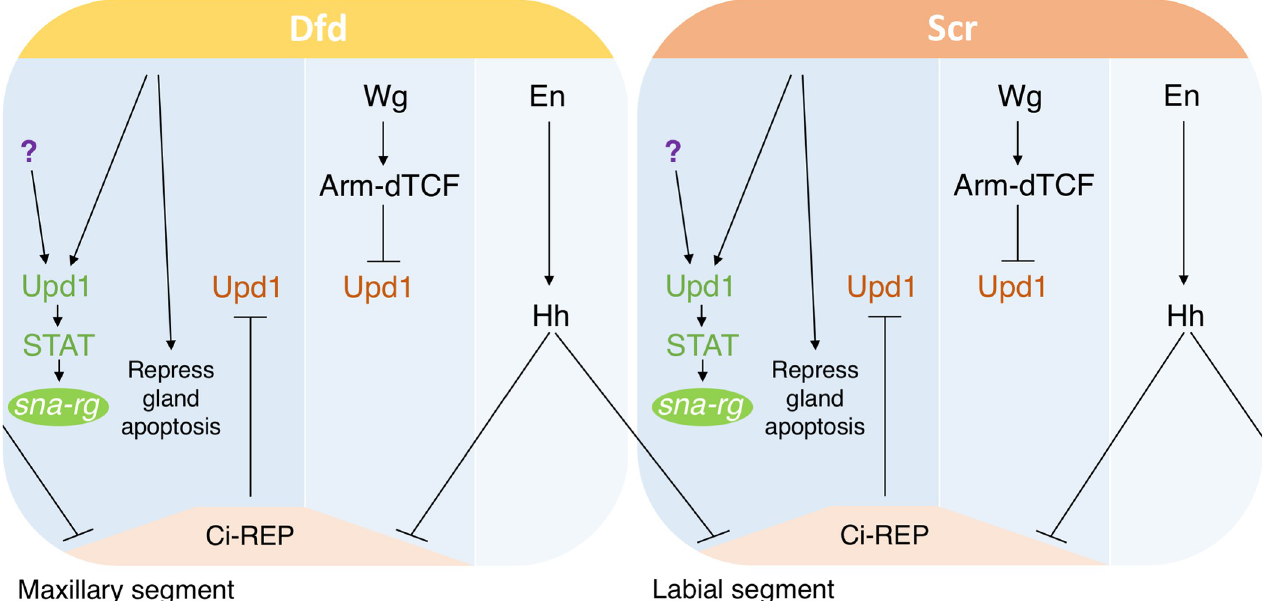
Fig 7. Regulatory gene-network controlling CA and PG specification. The regulation of the sna-rg enhancer in wild type embryos uncovers upstream factors mediating CA and PG specification. upd transcription is repressed directly or indirectly by both Ci and Arm-dTCF. Hh signalling from the posterior compartment releases the Ci repressive activity over upd transcription. Dfd and Scr proteins prevent the gland primordia from entering into apoptosis and also up-regulate Upd expression. Activated STAT induces sna transcription by direct binding to the sna-rg enhancer. Besides the Hox proteins, an additional factor (question mark) also contributes to upd expression in the maxilla and labium. This additional factor could be the activated form of the Ci protein or another factor still to be defined.